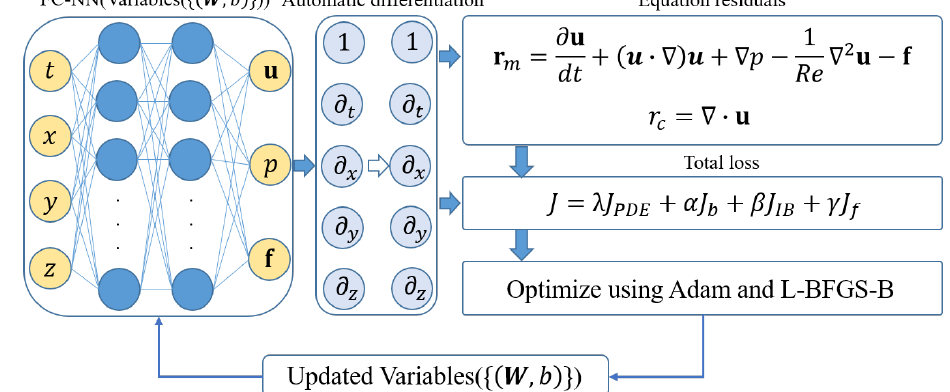
Figure 1. A schematic diagram of the IB-PINN framework for solving an incompressible Navier– Stokes equation. The left part is the architecture of the DNN used in the simulation. The middle part illustrates the computation of derivatives by using automatic differentiation. The right part shows the formula for computing the loss